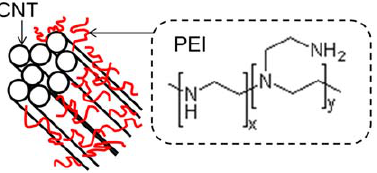
Figure 3. Schematic representation of PEI-functionalized CNT bundles in the composite and the structure of branched PEI. The amine groups are responsible for the electron donation which converts CNTs into n-type semiconductors. When the bundles are smaller, more tubes come in direct contact with PEI, which increases the n-type thermopower values. On the other hand, composites with large bundles have fewer junctions necessary for electron transport across the composite.